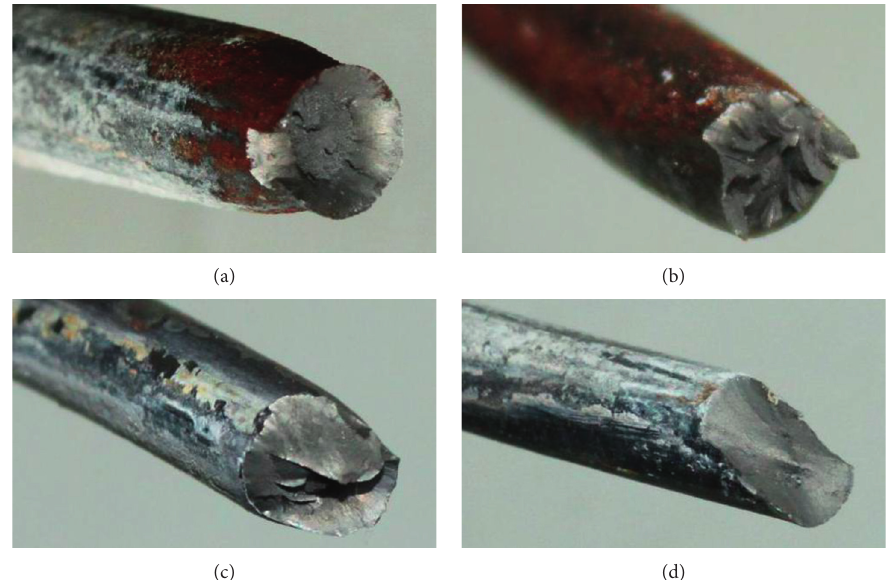
Figure 7: Fracture types of corroded steel strand wires: (a) cup-and-cone fracture; (b) milling-cutter fracture; (c) cleavage-milling-cutter fracture; (d) cleavage